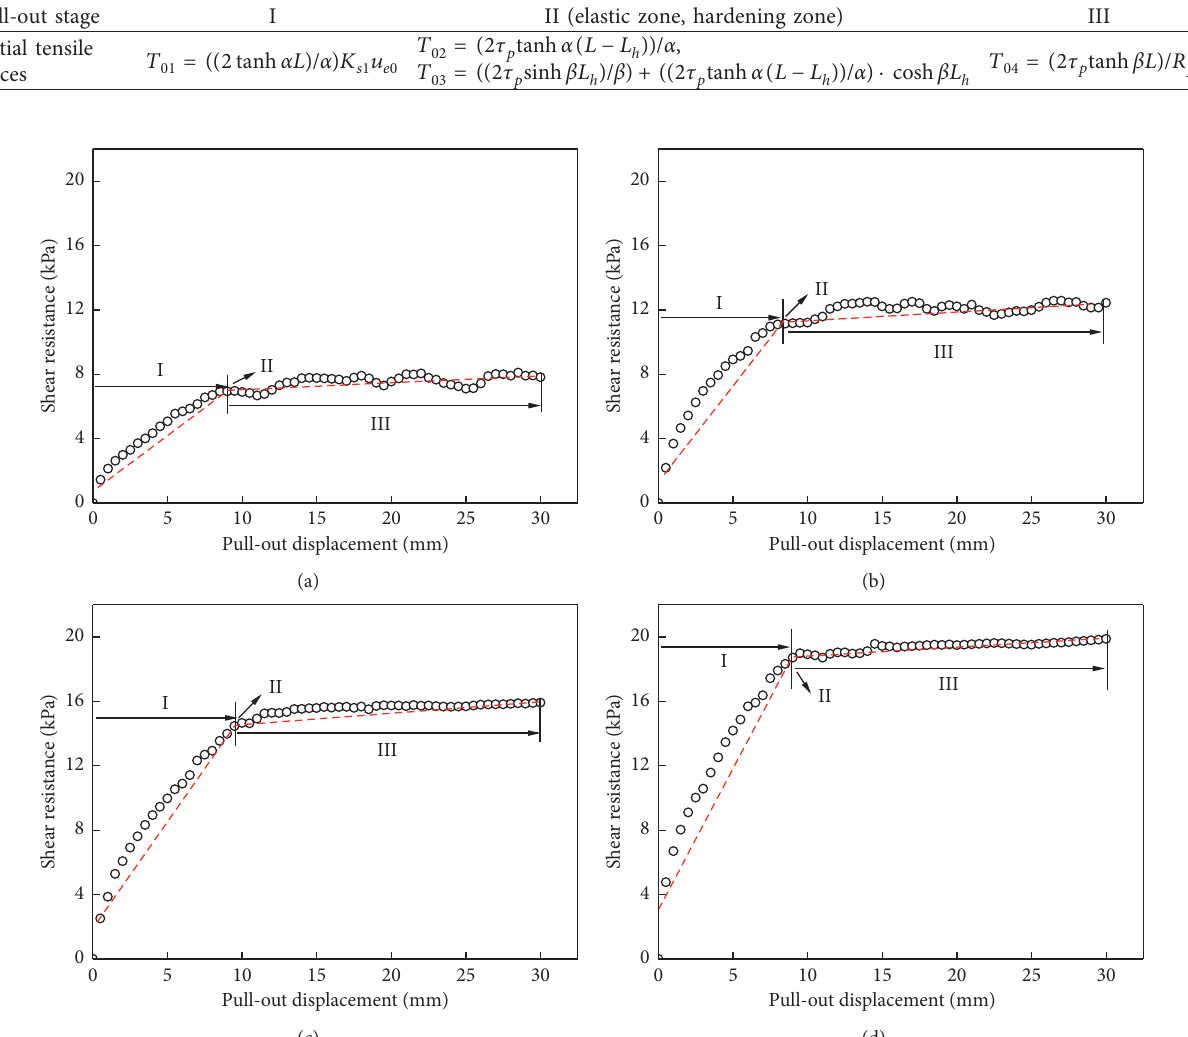
Table 3: Initial tensile forces at different stages of the hardening pull-out model.